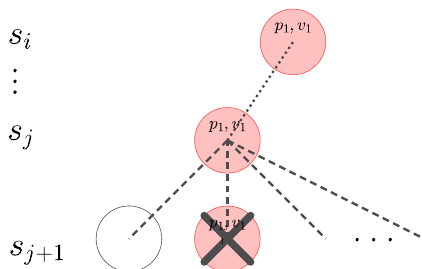
Figure 4. Solution tree traversal with jumps: After choosing to operate pump p 1 at speed v 1 at